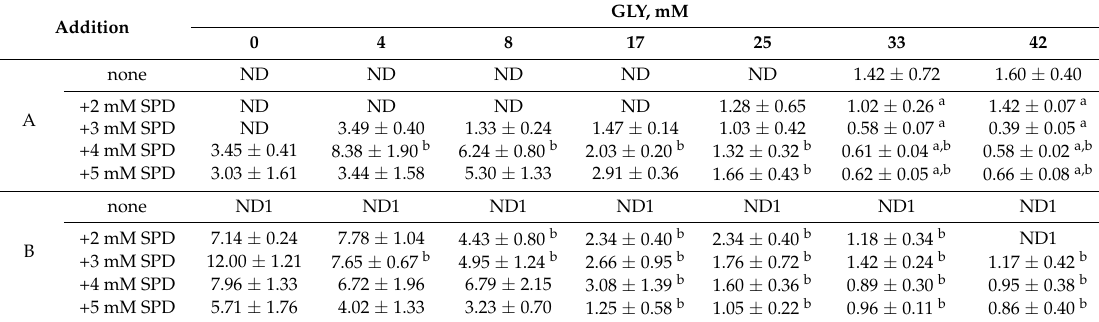
Table 1. Effect of different concentrations of spermidine (SPD) and glycerol (GLY) on the tensile strength (TS) (MPa) of native (A) and heat-denatured (B) bitter vetch (BV) protein films obtained at pH 8.0 *.